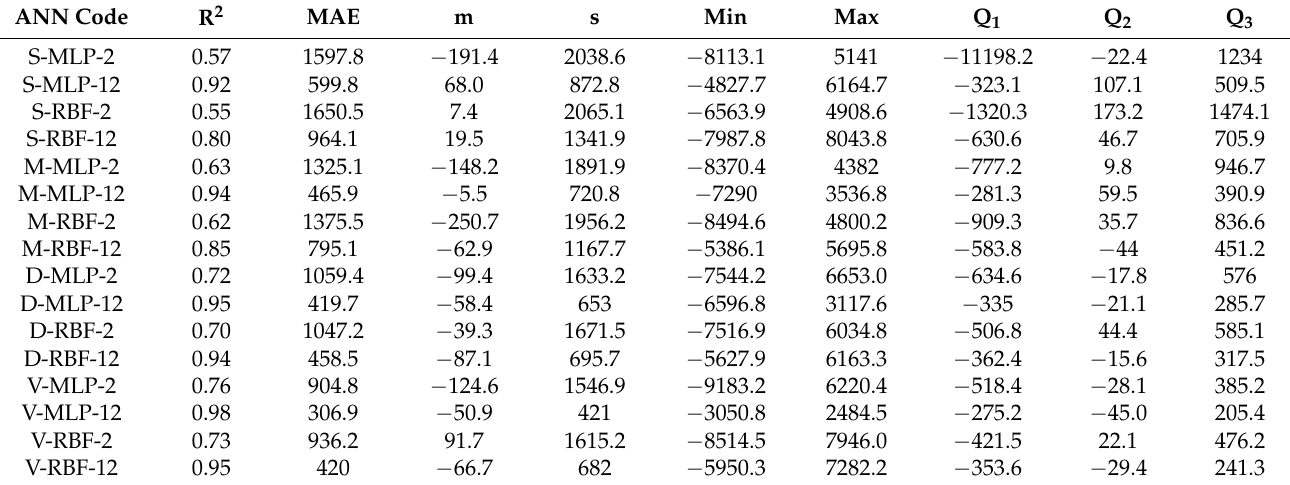
Table 9. Values of all statistical quantities calculated on residuals resulting from the validation process of all 16 neural networks tested.